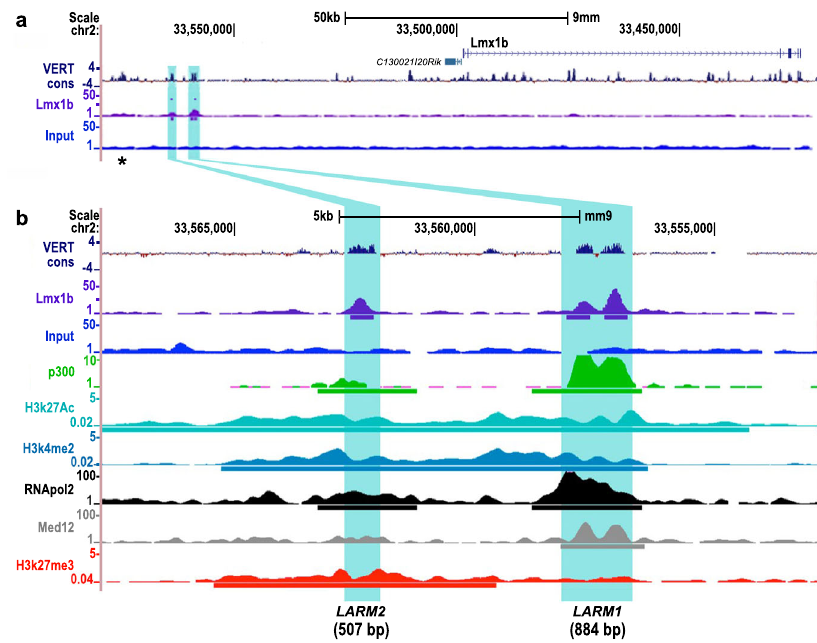
Fig. 1 LARM1 and LARM2 are conserved, bound by Lmx1b, and associated with active chromatin marks. a UCSC genome screenshot displaying the Lmx1b locus and the associated cis -regulatory modules LARM1 and LARM2 (highlighted in blue) showing vertebrate conservation (VERT cons), Lmx1b binding (Lmx1b-targeted ChIP-seq) 8 and input 8 . b Magni fi cation of the putative enhancer region displaying the overlap with active enhancer-associated regulatory marks present in limb buds. From top to bottom: vertebrate conservation (VERT cons), ChIP-seq tracks for Lmx1b 8 , control Input limb DNA 8 , p300 10 , histone 3 acetylation at lysine 27 (H3K27Ac) 11 , histone 3 dimethylation at lysine 4 (H3K4me2) 12 , RNA polymerase II 13 , Med 12 13 , and histone 3 trimethylation at lysine 27 (H3K7me3) 12 . Note that LARM1 consists of two conserved peaks, both of which are recognized by Lmx1b-targeted ChIP-seq 8 . Upstream of LARM2 , another conserved region is present (asterisk). This potential cis -regulatory module is also associated with the 9430024E24Rik gene 21 , but does not appear to be bound by Lmx1b, as shown in the Lmx1b-targeted ChIP-seq track (see also Supplementary Fig.